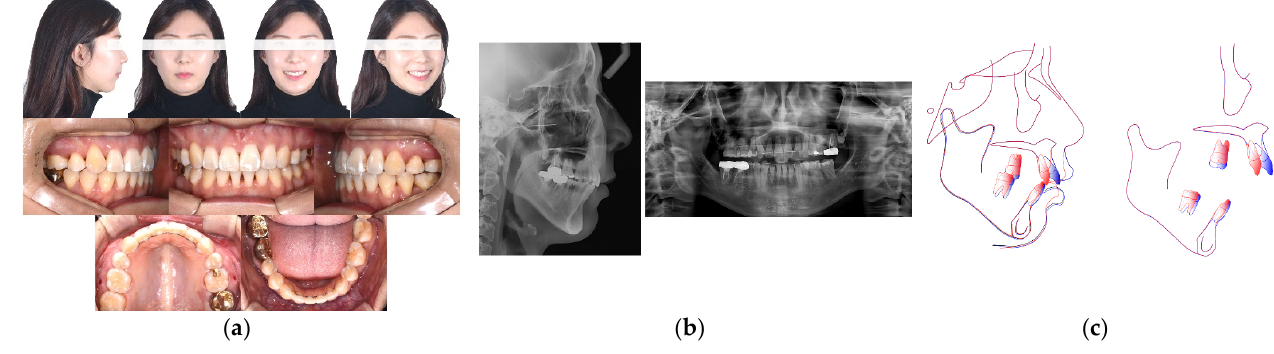
Figure 5. Post-treatment records: ( a ) facial and intraoral photographs, ( b ) lateral cephalogram and panoramic radiograph, and ( c ) cephalometric superimposition. Black, pretreatment; blue, post-stabilization; red, post-treatment.